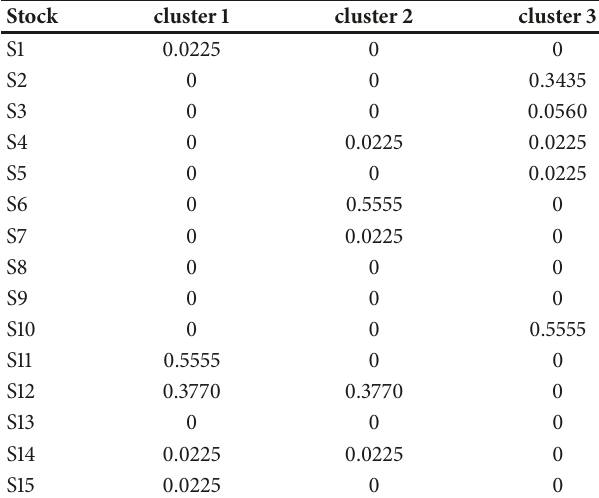
Table 11: Results for each